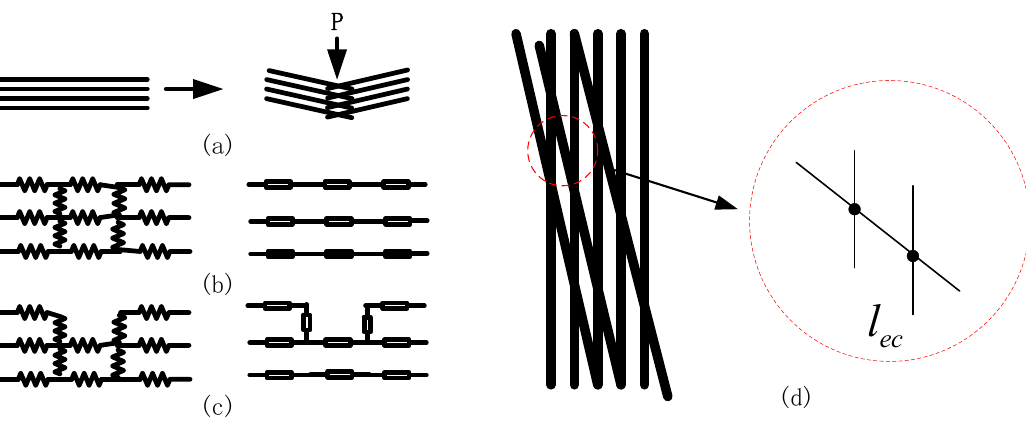
Figure 2. Two-dimensional micrograph of CFRP ( a ) CFRP under load and bending fracture; ( b ) electrical model of CFRP in good condition; ( c ) electrical model of damaged CFRP (The left half is the schematic model of the micro spring, and the right half is the resistance change model); and ( d ) schematic diagram of the electrically inactive length l ec of carbon fiber originating from the contact between the fibers.